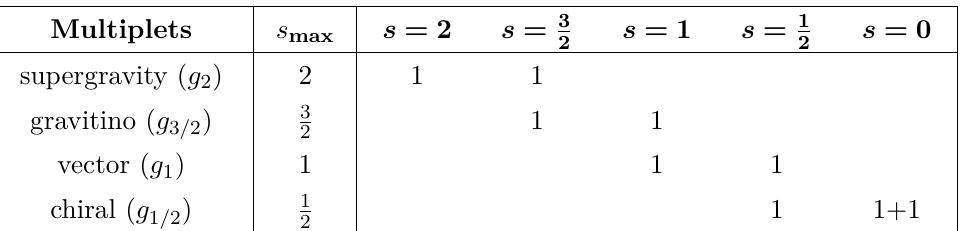
Table 2 . Different multiplets and spin content of a N = 1 , d = 4 EMSGT.